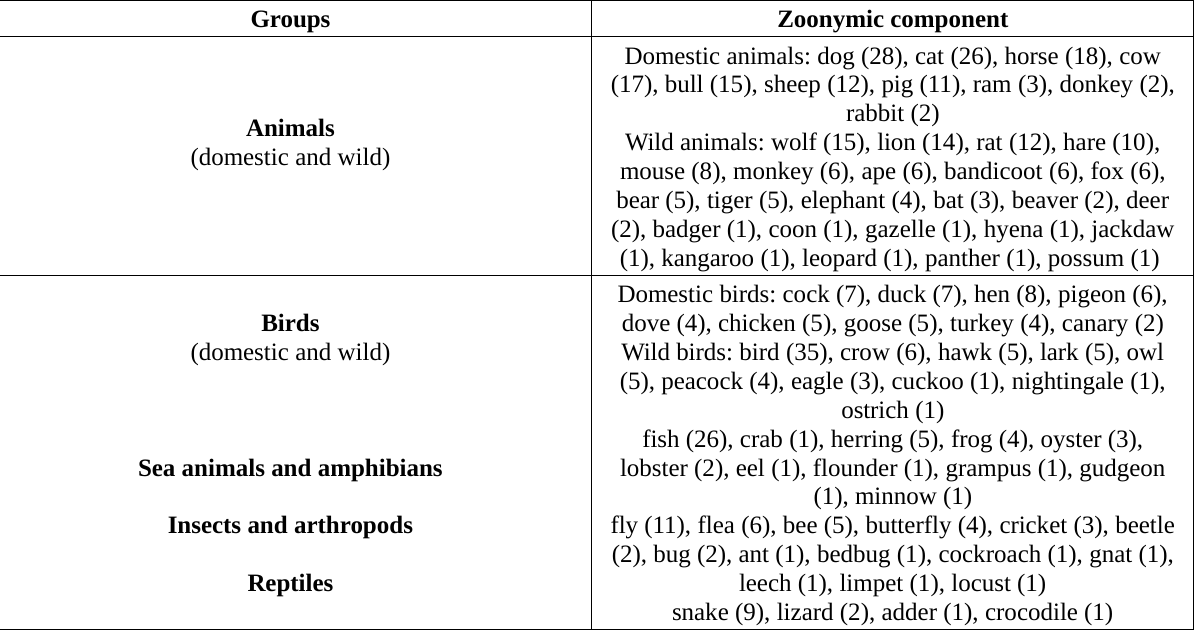
Table 1 - Zoonyms as part of phraseological units